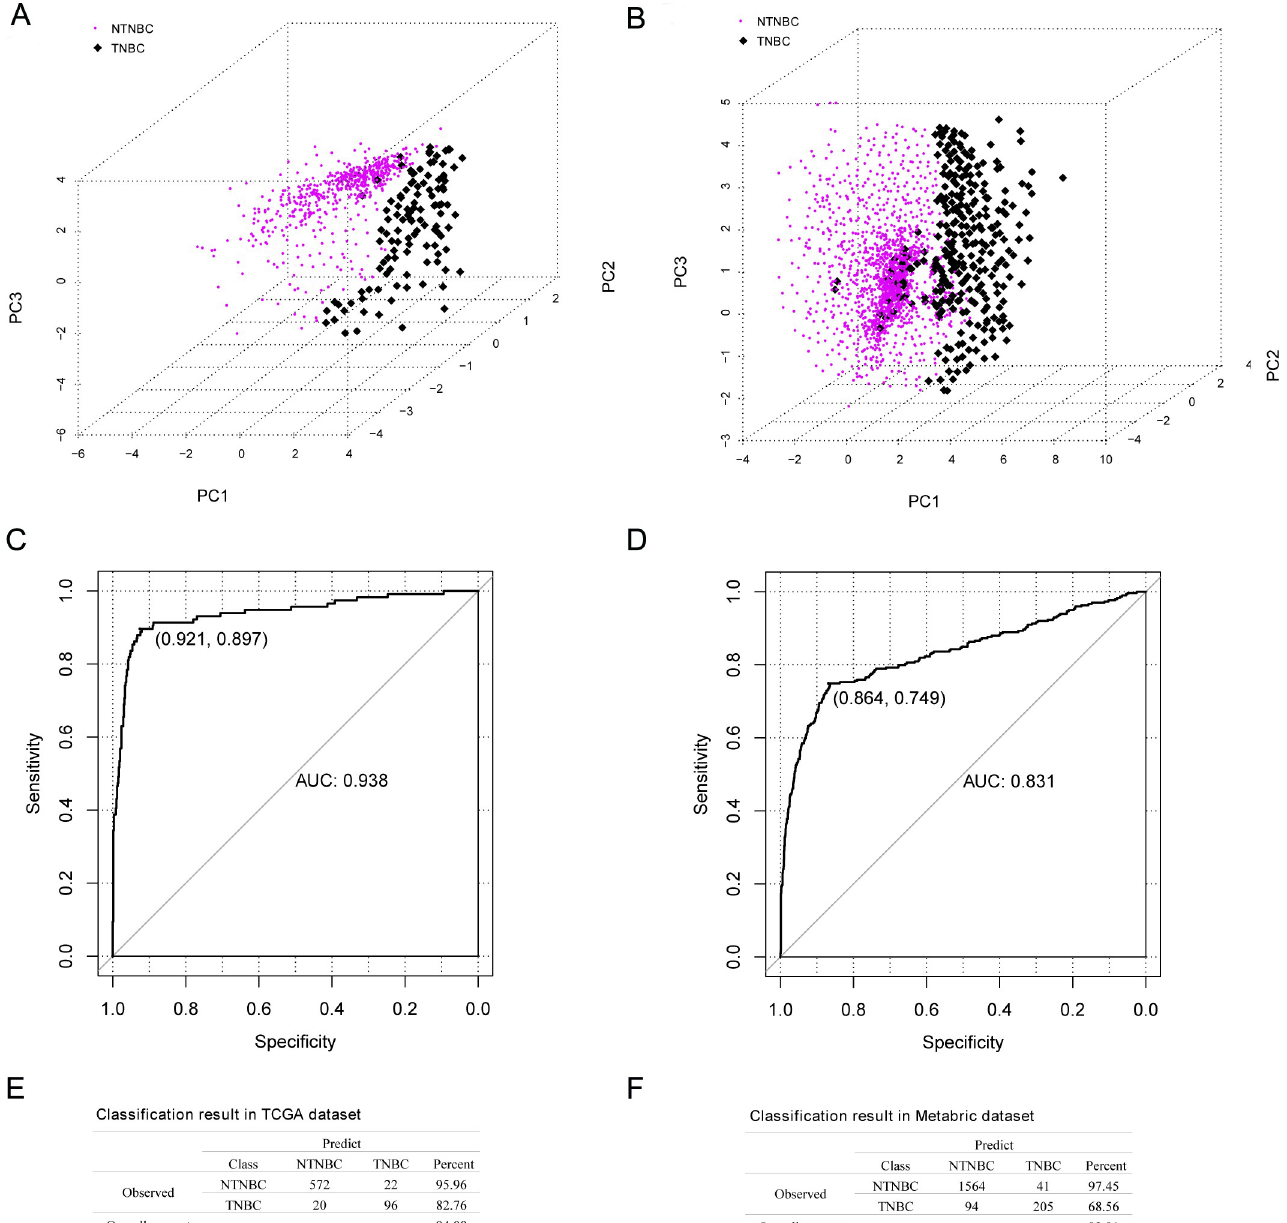
Fig 3. The Logit regression model analysis of TCGA training and METABRIC validation data sets. (A, B) represent the scatter distribution situation of TNBC and NTNBC. (C, D) represent the logistic regression model classification results. Five-mRNA signature precisely identified TNBC and NTNBC samples in the TCGA training and the METABRIC validation data sets. (E, F) exhibited the fuzzy classification matrix result in the TCGA dataset and Metabric dataset, which demonstrated the overall TNBC predictive percent of 94.08% and 92.91% compared to the predicted classification with the actual group. TNBC, triple- negative breast cancer; NTNBC, non-TNBC. TCGA, The Cancer Genome Atlas. Metabric, Molecular Taxonomy of Breast Cancer International Consortium. https://doi.org/10.1371/journal.pone.0260811.g003 Fig 4D], and with recurrence [HR = 9.362 (5.015–17.48), P < 0.0001; Fig 4G] induced a signifi- cantly lower survival rate than those were younger, at lower pathologic stage and without recurrence. OS showed no significant differences between the high- and low-risk groups for patients aged under 60, with early pathologic stage, and without recurrence ( P > 0.05; Fig 4B,